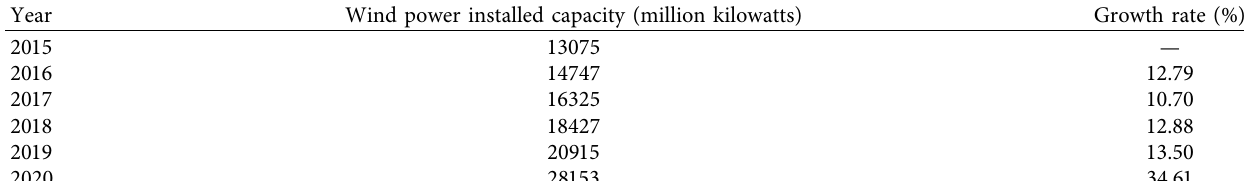
Table 5: Installed capacity and growth rate of wind power from 2015–2020.